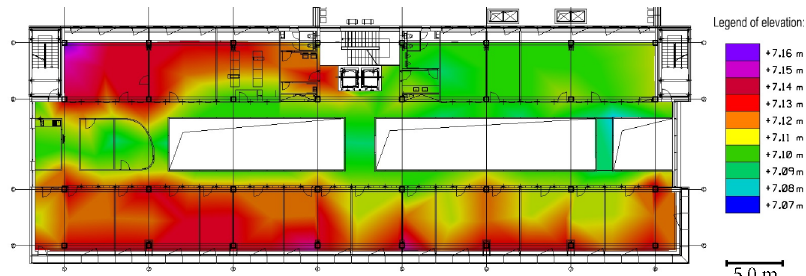
Figure 12. The colour hypsometry model of the 3 rd AGL floor with the legend of height conditions